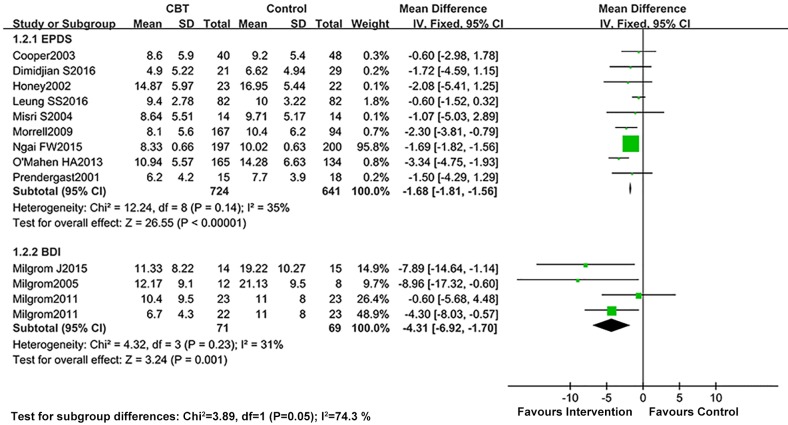
Combined results of EPDS and BDI scores comparing CBT vs. control conditions at long-term post-intervention: A random effects analysis.